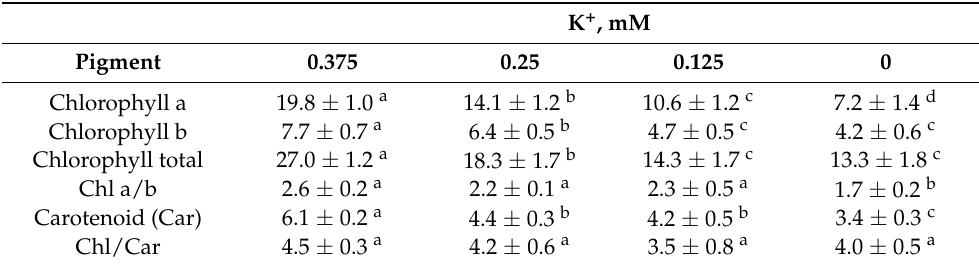
Table 2. Chlorophyll a, b, total and carotenoid contents (mg · g − 1 FW) of third-leaf-stage leaves of 64-day-old O. basilicum plants. Measurements were carried out after 30 days of treatment in the presence of varying K + concentrations (0.375, 0.25, 0.125 and 0 mM). Means of eight replicates and confidence intervals at the 5% level are presented. Values with the same letters as indicated in the Table are not significantly different according to Duncan’s test at p <